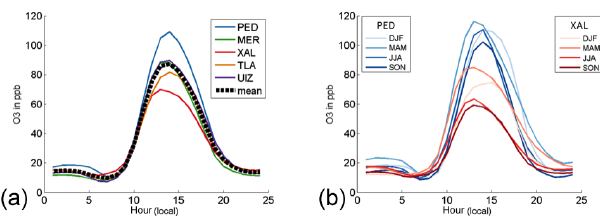
Figure 2. (a) Diurnal cycle of surface ozone concentrations (ppb) at five observing stations (colored lines), as well as the mean (black dotted line) for all seasons, 1986–2014. (b) Diurnal cycle of surface ozone concentrations for Pedregal (PED; blue lines) and Xalostoc (XAL; red lines) by season from the RAMA network, 1986–2014.